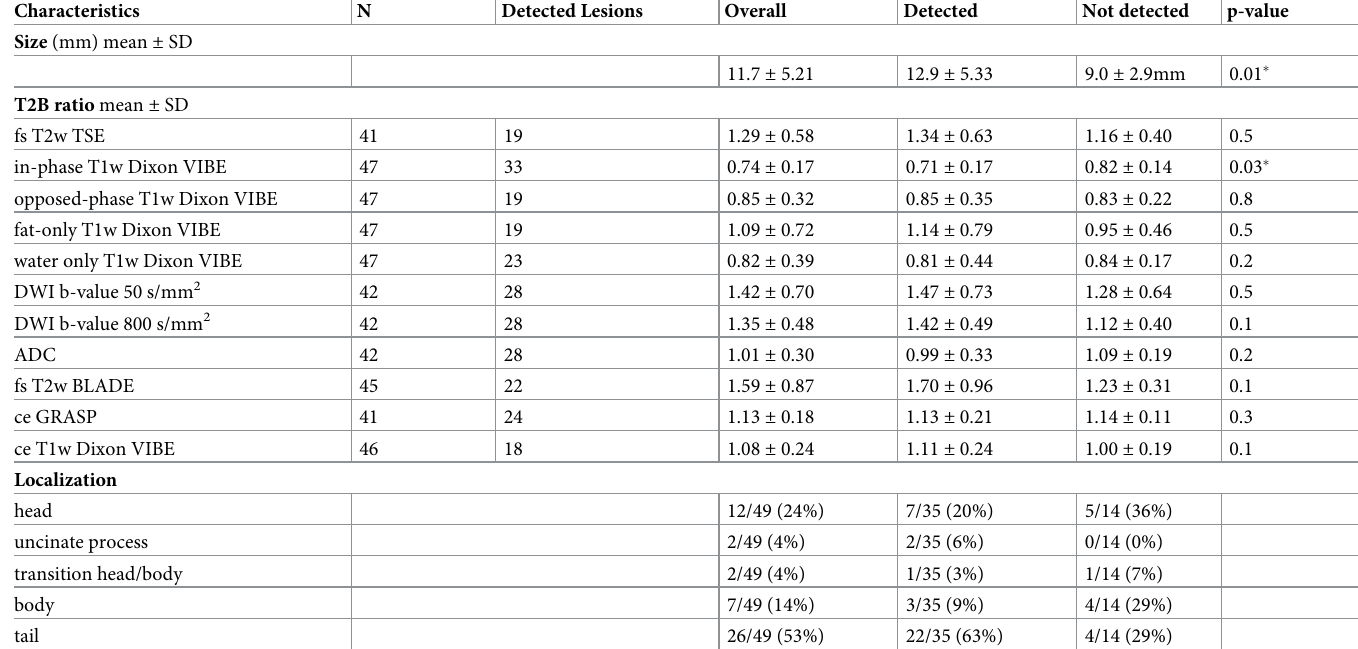
Table 4. Characteristics in 49 PICT compatible